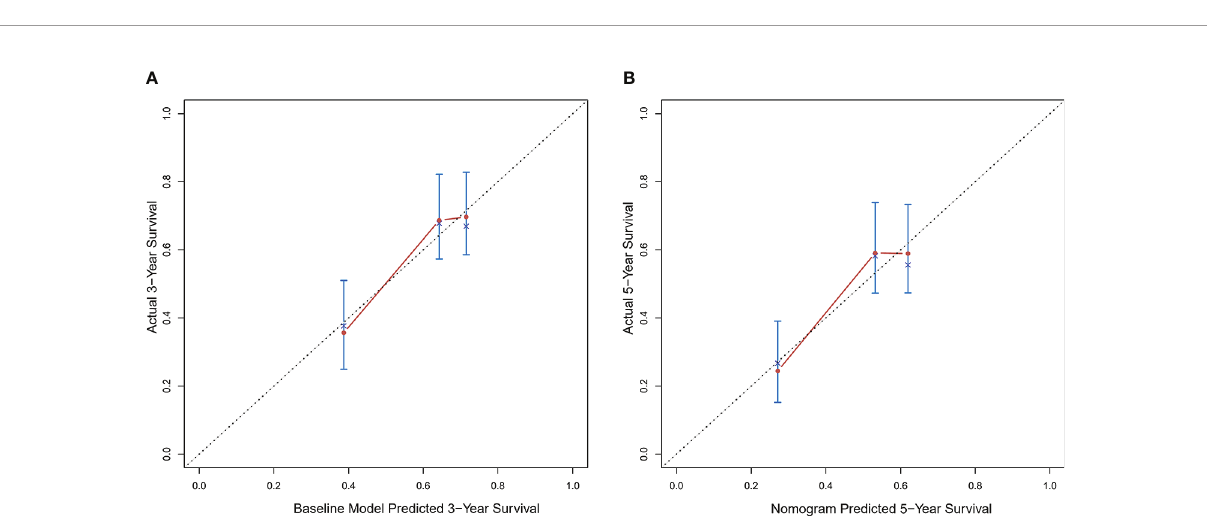
FIGURE 3 | Calibration curves of the prognostic nomogram for the (A) 3-year overall survival (OS) and (B) 5-year OS in the validation